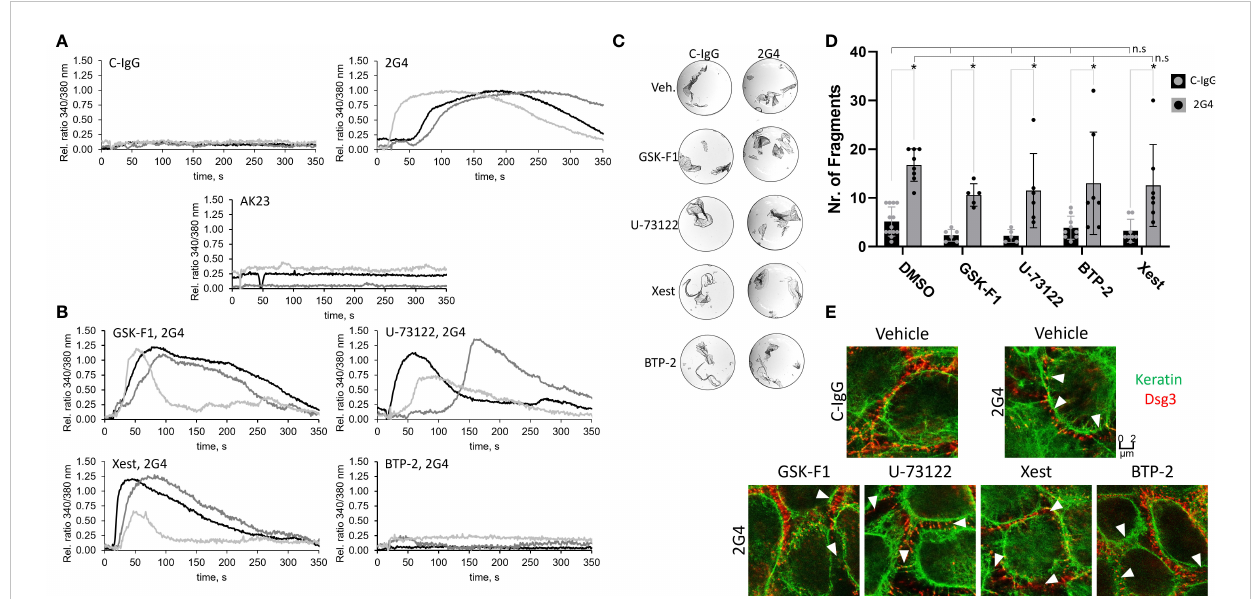
FIGURE 5 Alterations of intracellular Ca 2+ signalling induced by 2G4. (A) Changes in intracellular Ca 2+ -concentration determined in HaCaT cells, after addition of 2G4, AK23 or C-IgG, by a measured change in ratio of 340/380 nm fl uorescence of intracellular FURA-2AM upon Ca 2+ binding (One curve represents one independent experiment, N=3, obtained from the mean of 8 cells, n=8). (B) Changes in intracellular Ca 2+ -concentration after addition of 2G4 to HaCaT cells previously treated with inhibitors of the anti-Dsg1-IgG-dependent Ca-in fl ux pathway (see Table S2). (C) Representative images of dispase-based dissociation assay results after pre-treatment of HaCaT cells with Ca 2+ -in fl ux pathway mediators for 1 h. (D) quanti fi cation of the dispase-based dissociation assay results (N=5-13, * makrs statistically signi fi cant differences between the two conditions indicated, n.s. (not signi fi cant) indicates, that there are no signi fi cant differences to the corresponding C-IgG (negative) or 2G4 (positive) control condition, both in two-way-ANOVA with Sidaks correction for multiple comparisons, p<0.05). (E) STED images of cells pre-treated with vehicle or Ca 2+ -in fl ux pathway mediators for 1 h and C-IgG or 2G4 for 24 h. White arrowheads indicate fragmented Dsg3